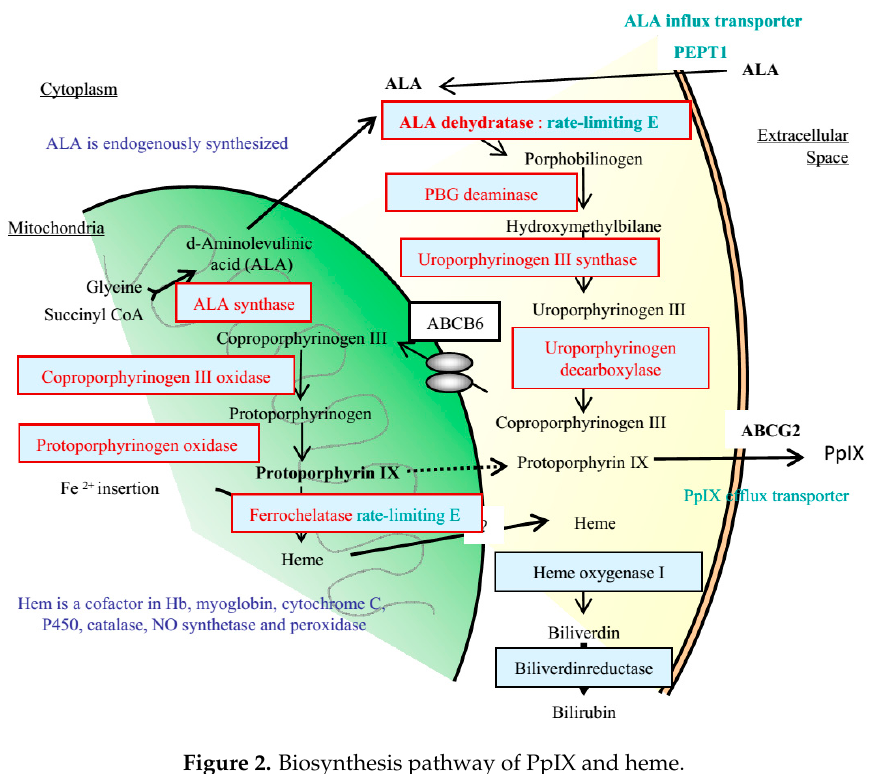
Figure 2. Biosynthesis pathway of PpIX and heme.